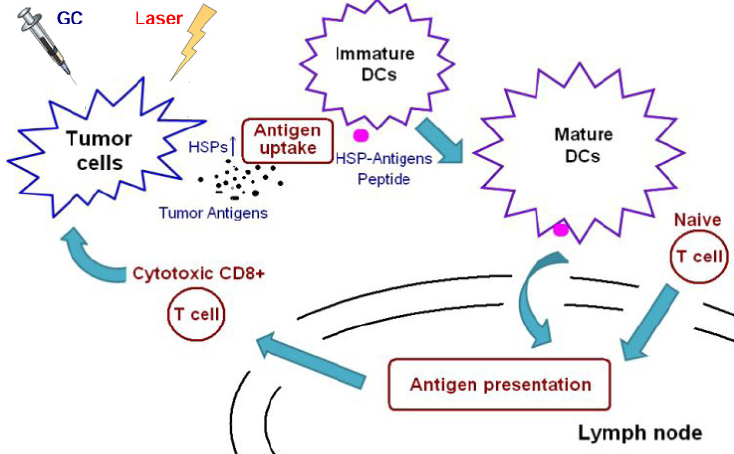
Fig. 5. The operation procedure and the working mechanism of laser – GC treatment of cancers. The laser irradiation causes the release of tumor antigens and heat shock proteins. GC injected to the treated tumor site recruits and activates antigen-presenting cells, such as dendritic cells (DCs). The activated DCs take up the tumor antigens and present them to the T cells. The activated T cells in¯ltrate tumors to eradicate residual tumor cells at the treatment sites and at the metastasizing